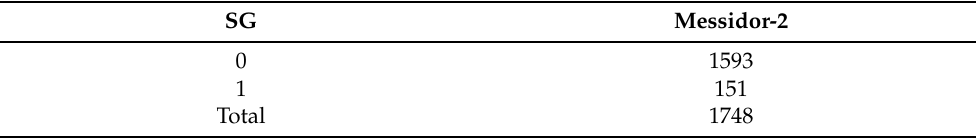
Table 2. Number of images of Messidor-2 corresponding to two different severity grades (SG) of disease.